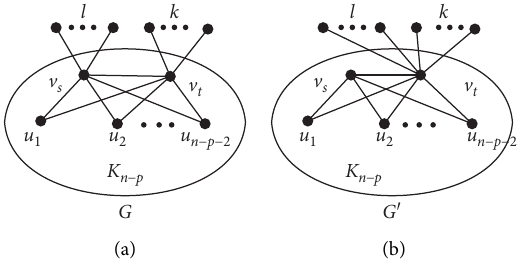
Figure 1: G and G ′ used in Lemma 1.